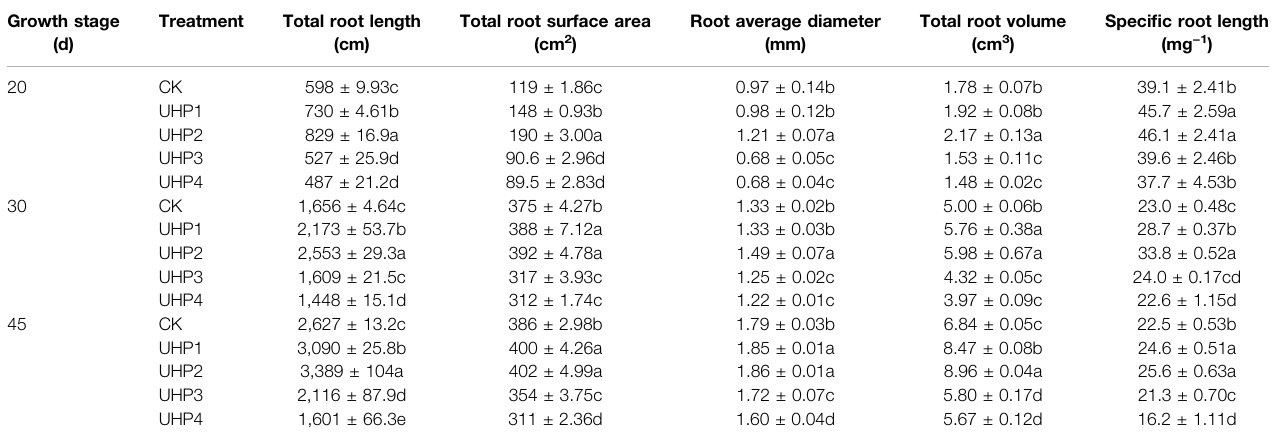
TABLE 2 | Effects of aeration on root architecture of amaranth at different growth